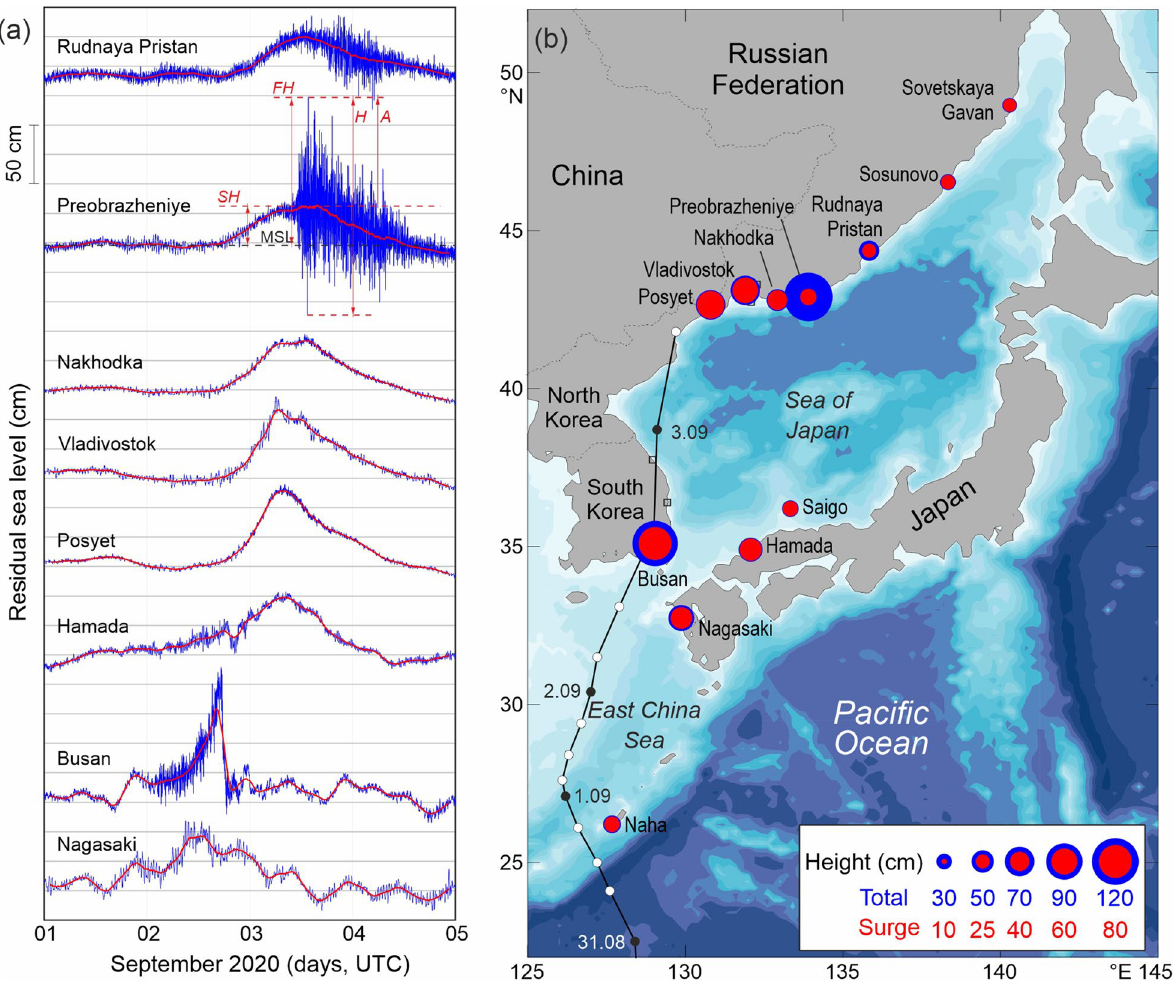
Figure 3. ( a ) Residual (de-tided) sea level records at eight stations during the passage of Typhoon Maysak; the thick solid red curves show the low-frequency component associated with the storm surge; ( b ) the September 2020 track of Typhoon Maysak and locations of the tide gauges used in this study; the circle size corresponds to the total flood height (blue) and surge height (red) above the mean sea level. The maximum observed flood height ( FH ), surge height ( SH ), amplitude ( A ) and height ( H ) of seiches/IG-waves are illustrated for the sea level curve at Preobrazheniye. Map was created with MATLAB 2021 using GEBCO bathymetry product. Subplots were combined and edited with CorelDraw